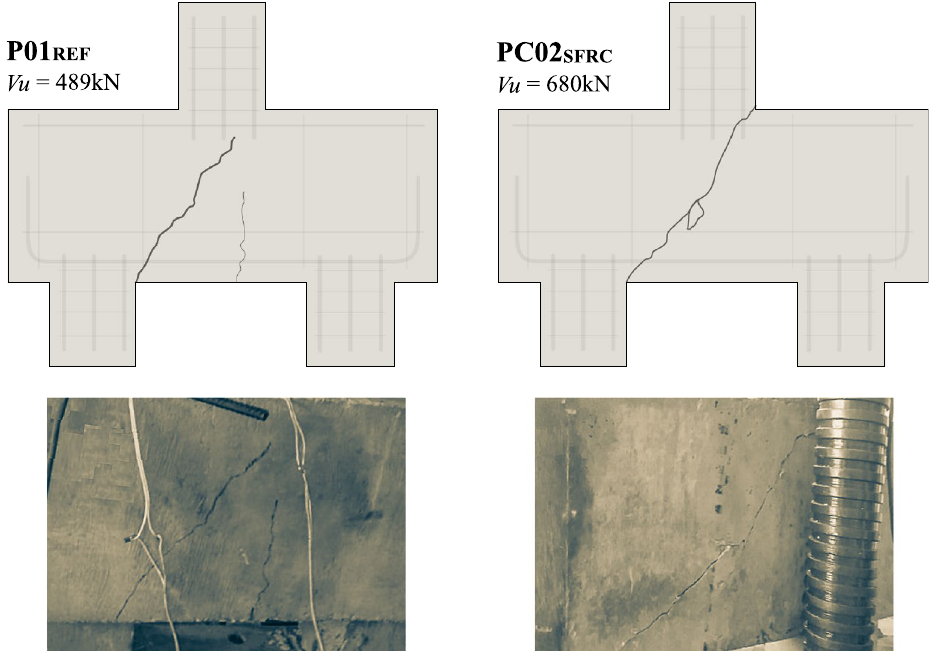
Figure 13. Final aspect of the pile caps after their failures without inclined shear reinforcement.